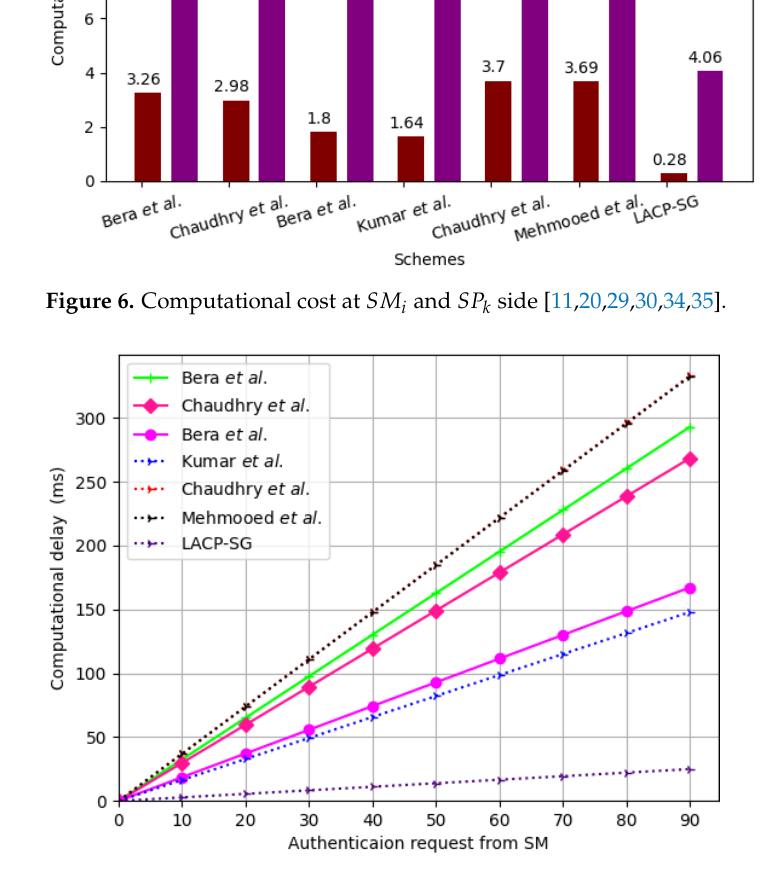
Figure 7. The computational cost increases with the number of authentication requests